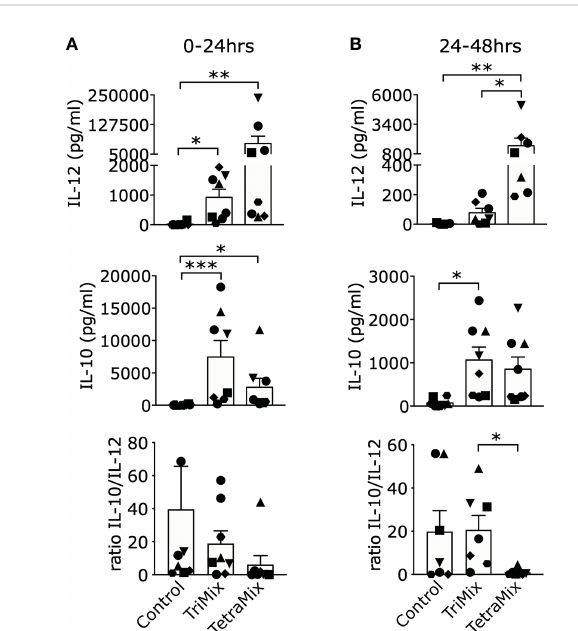
FIGURE 5 Interleukin-12 (IL-12) and IL-10 cytokine secretion pro fi les of DCs reprogrammed with TriMix or TetraMix mRNA. (A) Bar graphs representing the concentration of IL-12 or IL-10 detected in the supernatants of moDCs electroporated with tNGFR (control mRNA), TriMix or TetraMix mRNA, 24 hours post-electroporation. The lower graph shows the IL-10/IL-12 concentration ratio. (B) Bar graphs representing the concentration of IL-12 or IL-10 detected in the supernatants of control DCs, TriMixDCs or TetraMixDCs between 24 and 48 hours post-electroporation. The lower graph shows the IL-10/ IL-12 concentration ratio. Results are shown as mean value ± standard error of the mean and for 8 independent experiments (n=8). Each symbol represents the data of an individual donor. Statistical signi fi cance is indicated as follows: *p < 0.05, **p < 0.01, ***p < 0.001, by Friedman ’ s test.